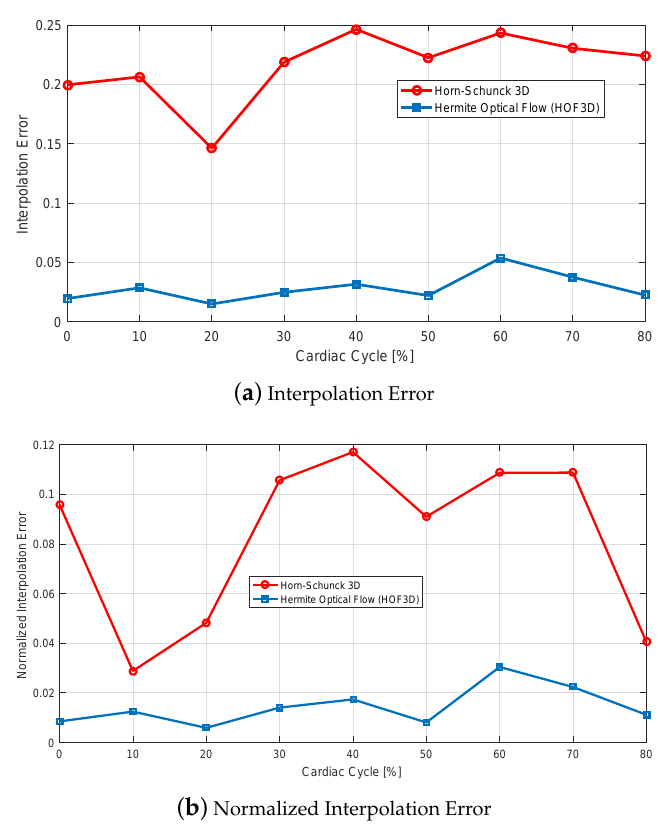
Figure 12. Interpolation Error and Normalized Interpolation Error. For the 3D Horn-Schunck (red dashed line) and Hermite Optical Flow in 3D (blue solid line) methods. From sequences of cardiac CT